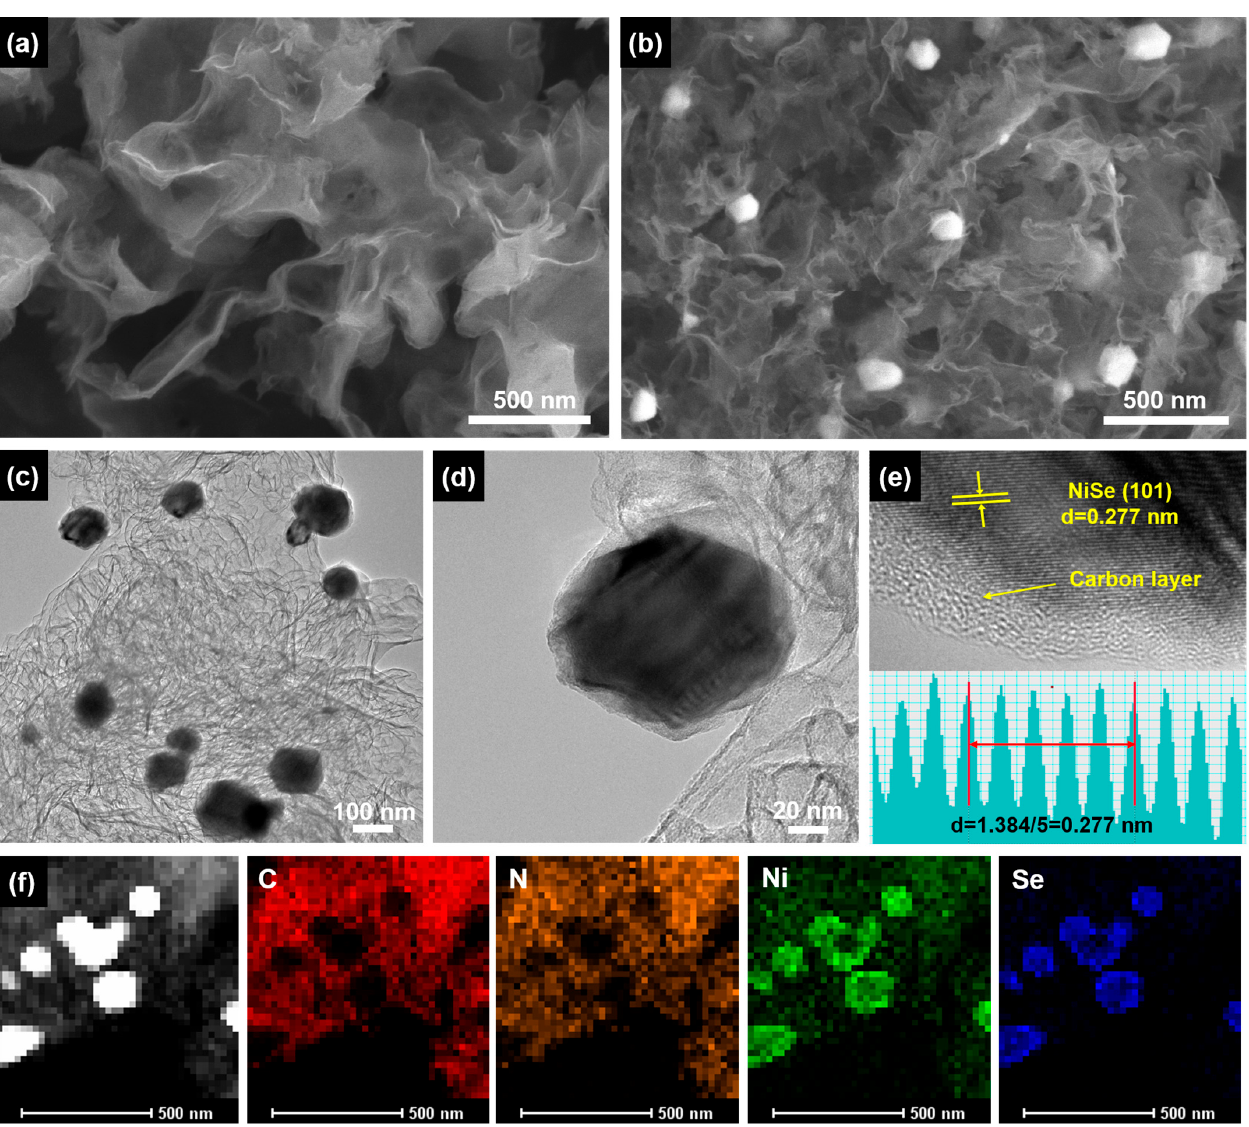
Figure 1. Morphology characterizations: ( a ) SEM images of Ni − N − C; (b) SEM images; ( c – e ) HR − TEM; ( f ) HAADF − TEM and EDS elemental mapping of NiSe/Ni − N − C. The solid − state compositions of the materials were investigated by X − ray diffraction (XRD). As shown in Figure 2a, Ni − N − C only demonstrated peaks corresponding to the carbon backbone, confirming the atomic distribution of Ni instead of Ni NPs. In diffraction pattern of NiSe/Ni − N − C, which matched standard NiSe (PDF#89 − 7160) very (Figure 2b). All synthesized materials showed the characteristic G band and D band, originating from the ordered graphitic carbon backbone and disordered defect structures, respectively; thus, the intensity ratio of D band over G band (I D /I G ) is widely applied to evaluate the degree of defect and edge in the carbon backbone [40]. Compared to that of NiSe/N − C (1.01), I D /I G of Ni − N − C and NiSe/Ni − N − C increased to 1.06 and 1.04, respectively, indicating that the introduction of single atomic sites improved the defect level as well as the exposure of active sites on the doped carbon framework. This result was also verified by the N 2 uptake test. All three materials showed typical type − IV isotherms, indicating the existence of hierarchical porous structures with microporosity